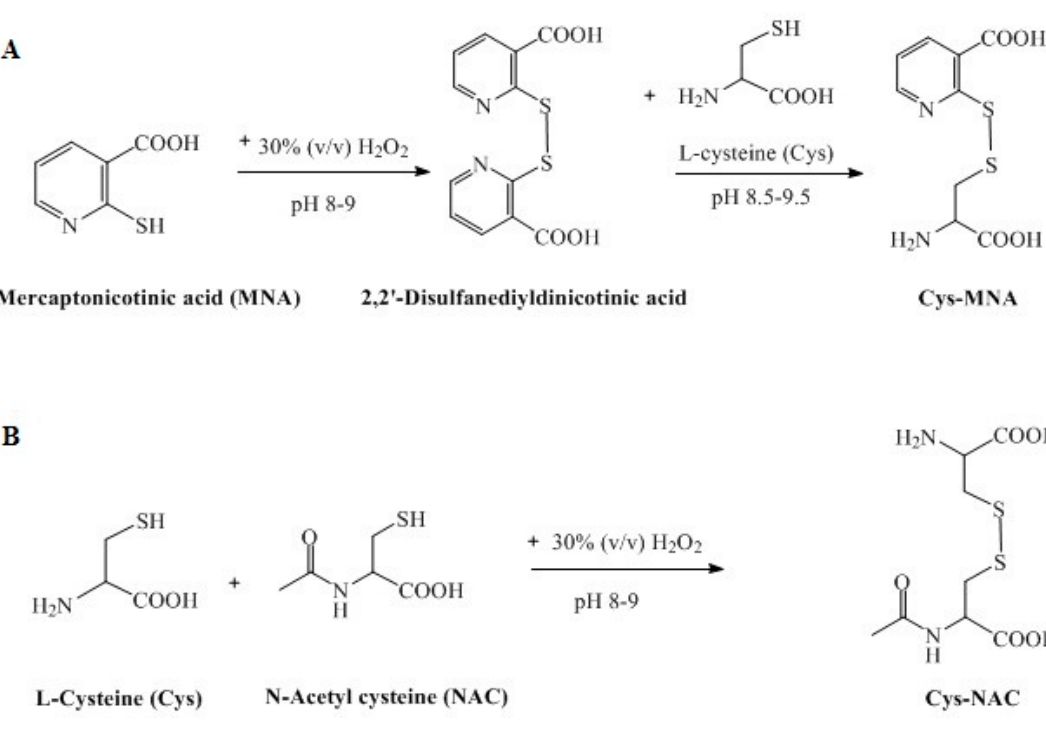
s -protected thiolated ligands: Cys-MNA ( A ) and Cys-NAC ( B Figure 1. Synthesis of S-protected thiolated ligands: Cys-MNA ( A ) and Cys-NAC ( B ). Figure 1. Synthesis of